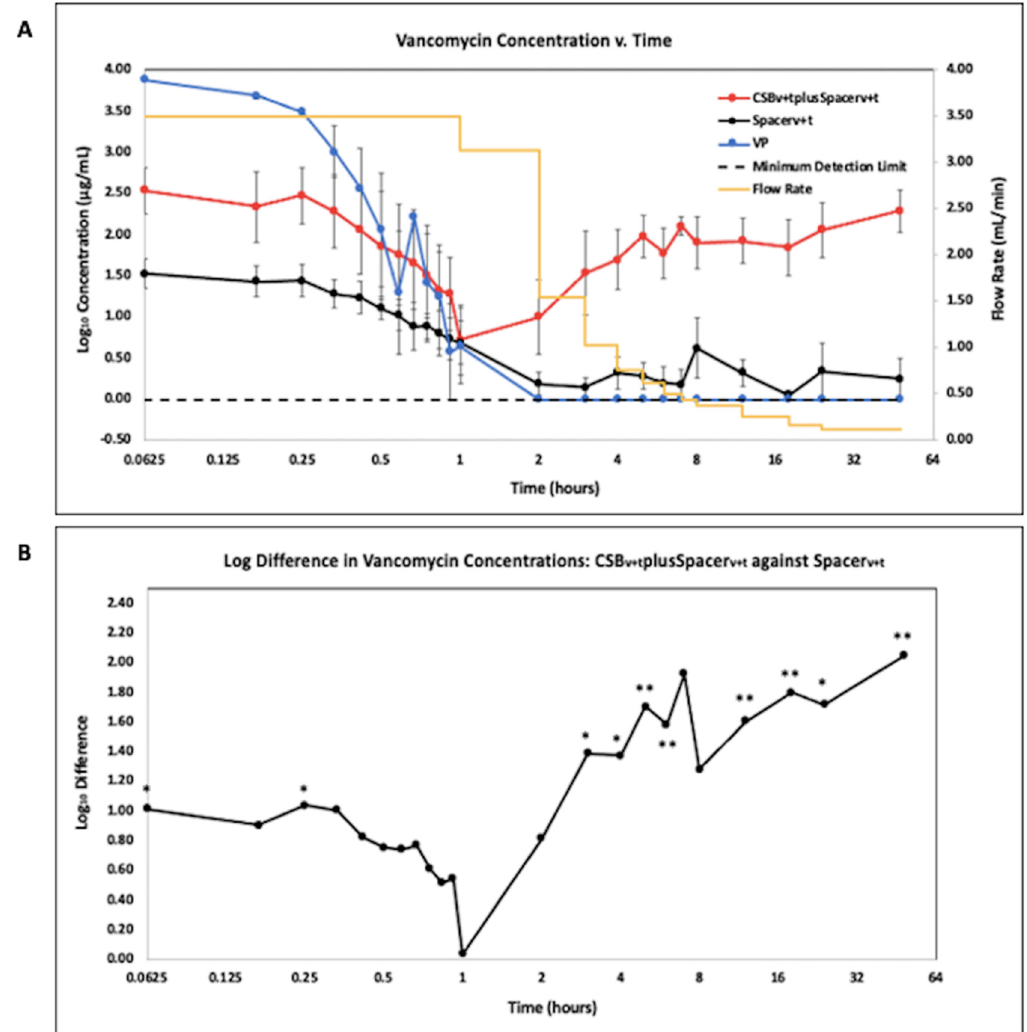
Figure 3. ( A ). LCMS analysis of vancomycin in effluent samples from antibiotic loaded calcium sulfate beads with an antibiotic loaded PMMA spacer (CSB v+t plusSpacer v+t ), antibiotic loaded PMMA spacer (Spacer v+t ), and vancomycin powder bolus (VP). N = 9; geometric mean ± SE. The yellow curve is the influent saline flow rate. Time is shown on a log2 scale to more clearly show the changes in concentration at the early time points. ( B ). Log difference of vancomycin effluent concentrations of the CSB v+t plusSpacer v+t compared to the Spacer v+t alone. (* p < 0.05, ** p < 0.01).